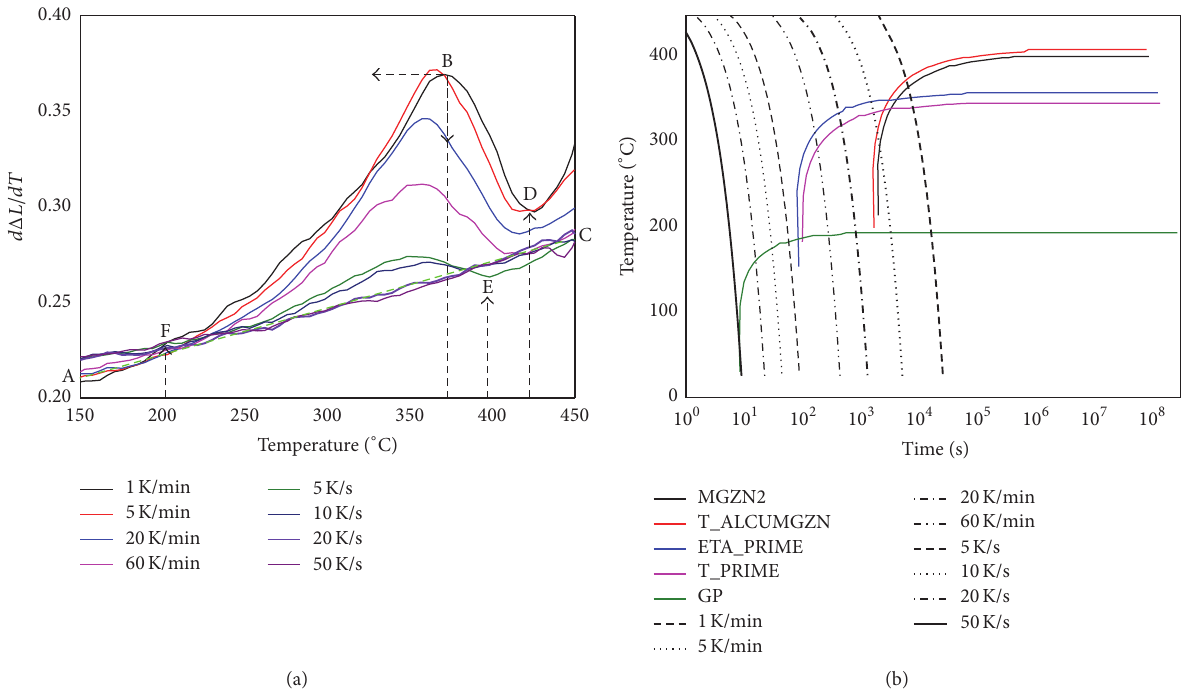
Figure 5: (a) DIL curves for AA7921 measured at various cooling rates between 1Kmin −1 and 50 K s −1 . (b) Simulated CCTdiagram of AA7921 from JMATPRO software.